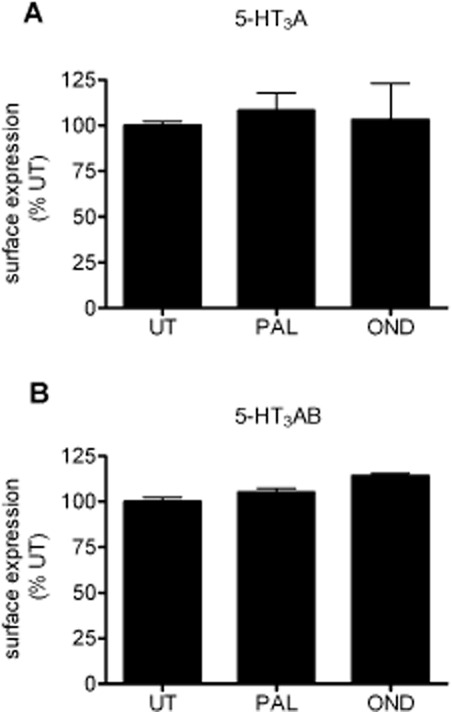
Cell surface levels of 5-HT3 receptors are not altered by palonosetron treatment. Cell surface ELISA was performed on COS-7 cells expressing 5-HT3A-myc (A) or 5-HT3A-myc/B-HA receptors (B), probing with anti-myc or –HA antibodies, respectively. Cells were incubated with palonosetron (PAL, 1 nM) or ondansetron (OND, 30 nM) for 150 min at 37°C and then fixed to prevent further membrane trafficking. Cell surface receptors were then probed using ELISA. Data are an average of three experiments performed in octuplicate and normalized to untreated (UT).